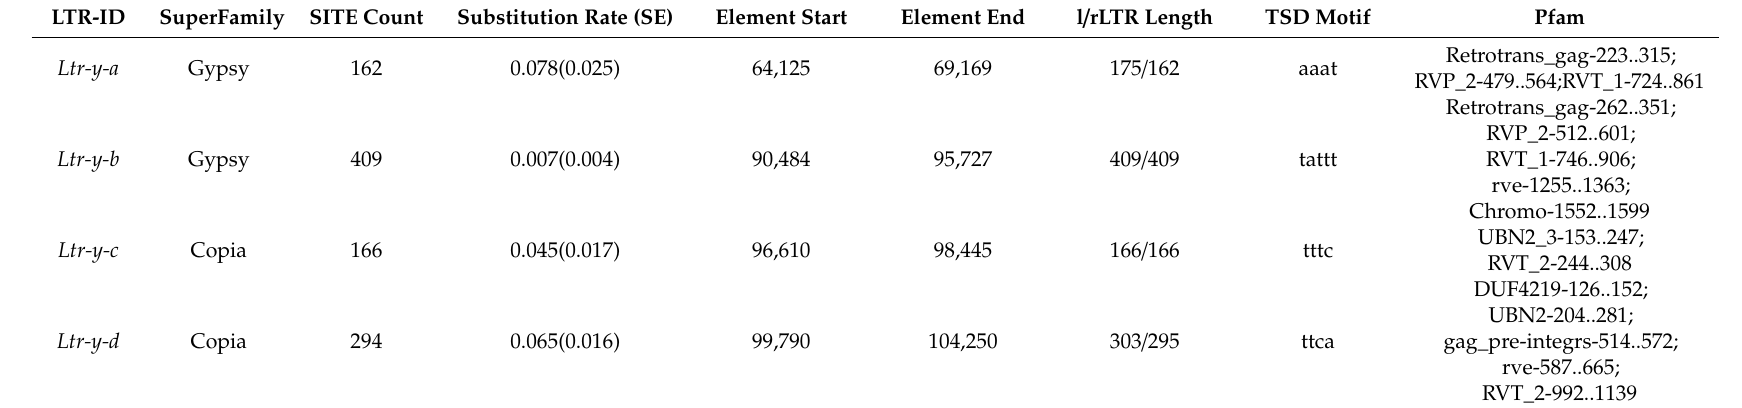
Table 2. Four autonomous long terminal repeat (LTR) identified in the